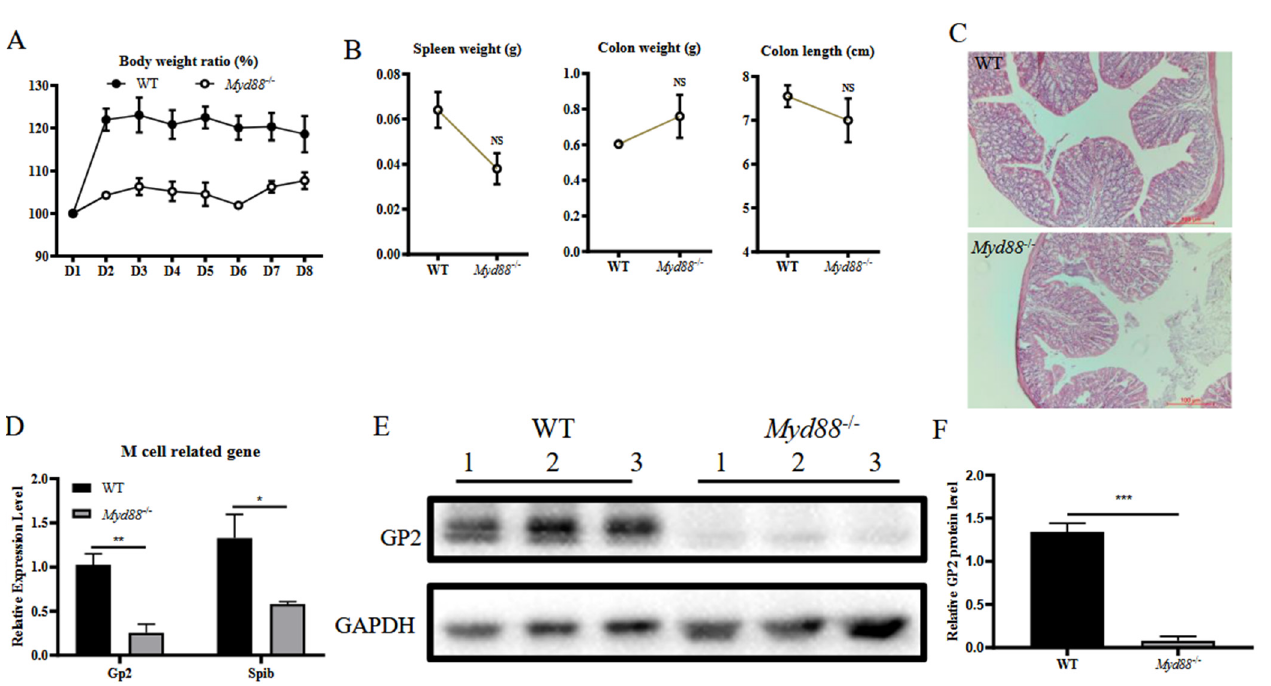
Figure 3. MyD88 is a critical factor for colonic M cell differentiation. The body weight of WT and MyD88 − / − mice ( n = 3) were monitored for 8 days ( A ). After sacrificing, their spleen weight, colon weight, and colon length were measured ( B ). Partial colon samples were fixed for histological analysis ( C ). Total RNA from colon samples was used to detect the mRNA levels of GP2 and Spi-B by RT-qPCR ( D ). The data were calculated using the 2 − ∆∆ Ct method. The GP2 expression levels in complete protein from colon samples were evaluated by Western-blot ( E ). Relative GP2 protein level was determined from the band intensity using ImageJ software ( F ). In all graphs, data are shown as ‘mean ± SEM’. Results were designated with: NS, p > 0.05; * p < 0.05; ** p < 0.01; *** p <